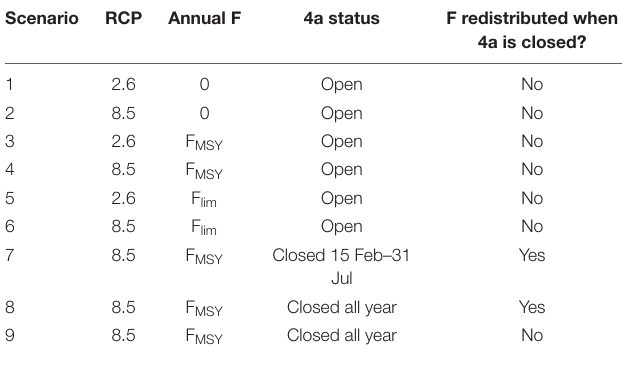
TABLE 2 | Summary of the multi-stressor future